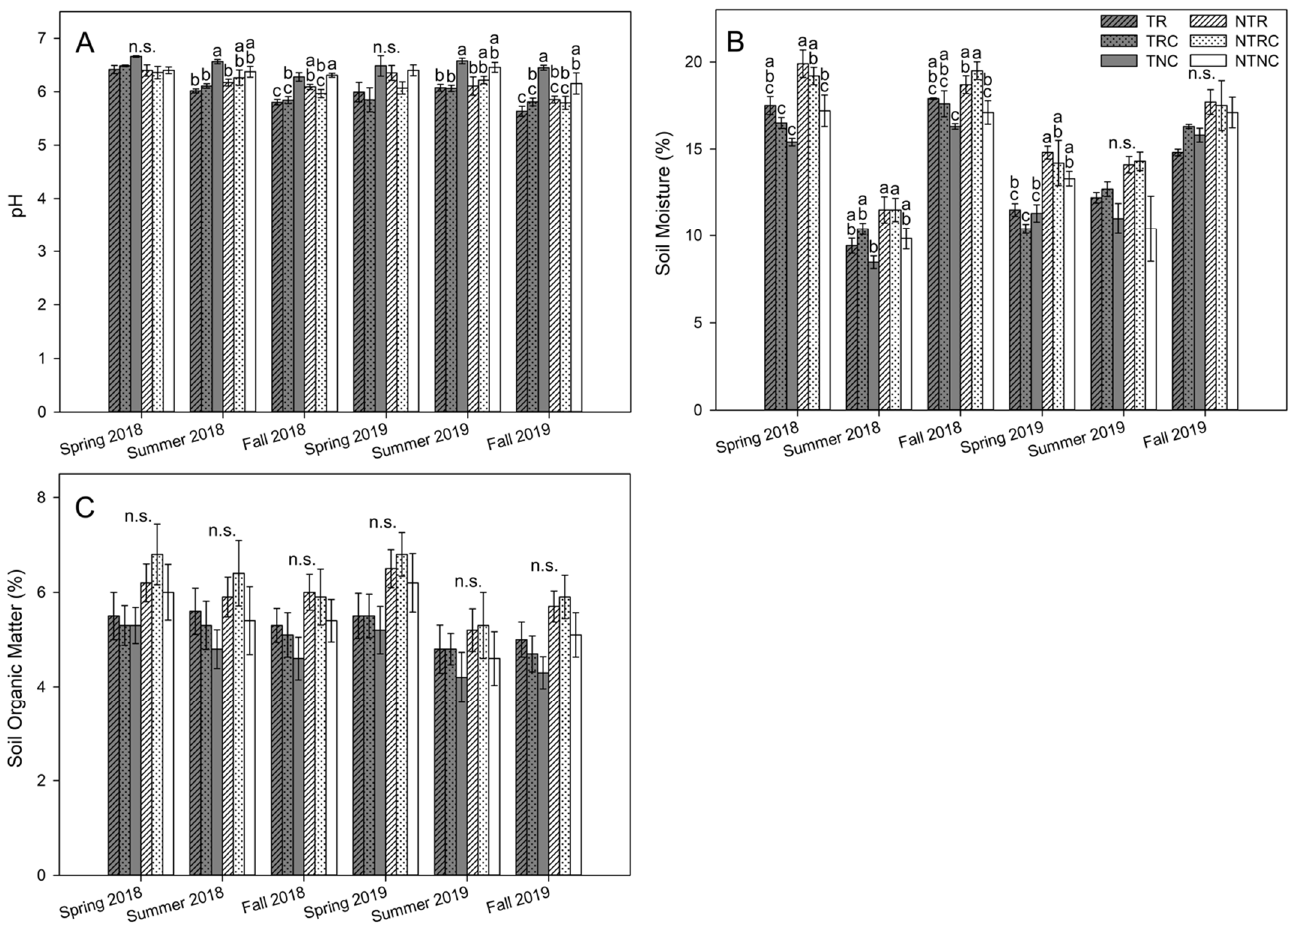
Figure 3. Soil pH ( A ), soil moisture content ( B ), and soil organic matter ( C ) in 0–5 cm depth from soybean study plots during 2018 to 2019 growing seasons. Values represent the mean ± standard error (n = 4). Statistical significance between treatments for each timepoint are denoted by different letters ( α = 0.05). Timepoints marked with n.s. indicate no significant differences between pairwise comparisons. Table 1. Soil chemical traits in 5–15 cm soil in spring 2018 and 2019 *.